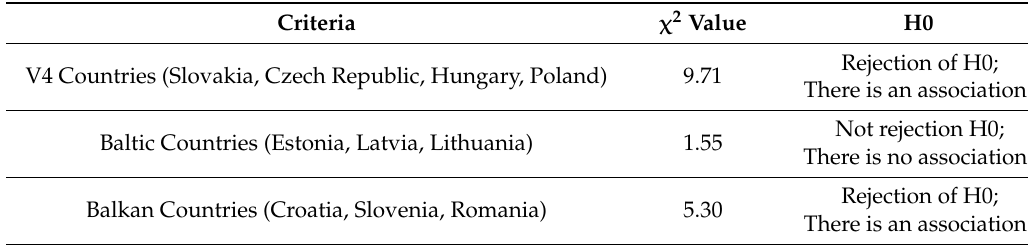
Table 3. Results for banks belonging to different groups of Central and Eastern European (CEE) countries related to number of efficient banks in the group of